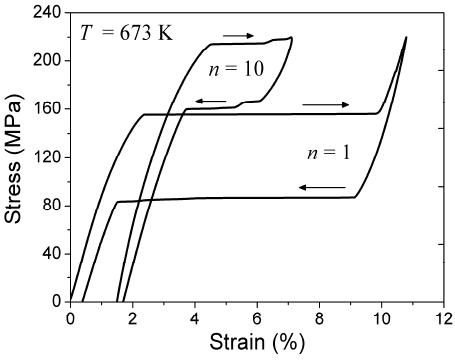
Figure 9. The influence of mechanical cycling on the superelastic behavior of Sample 2 of Ni Mn Ga single crystal. 57.5 22.5 20.0